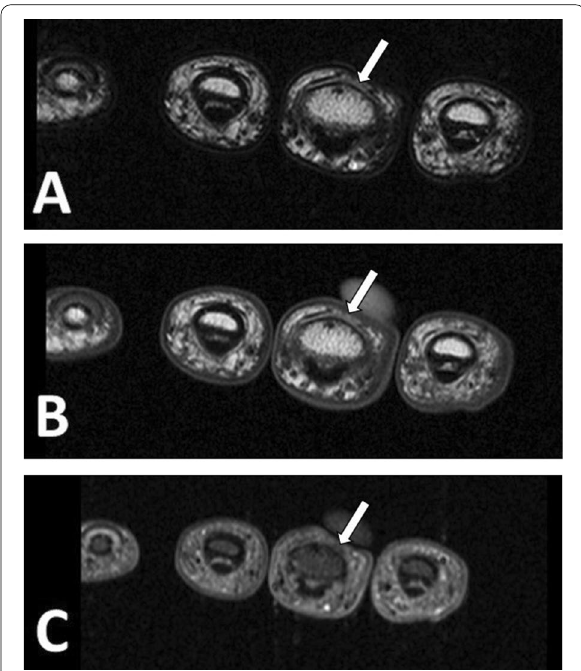
Fig. 6 Male patient 28 years old, complaining of weakness in extension of the middle finger of the right hand with remote history of hand trauma. Axial T2WI ( a ), axial T1WI ( b ) and axial STIR ( c ) weighted imaging of the right middle finger at the level of the proximal interphalangeal joint (PIP) showed abnormally thinned out lateral band of the extensor apparatus of the middle finger (white arrow) with preserved thickness of the medial band of the similar apparatus. Diagnosis partial tear of the lateral band of the extensor apparatus of the right middle finger